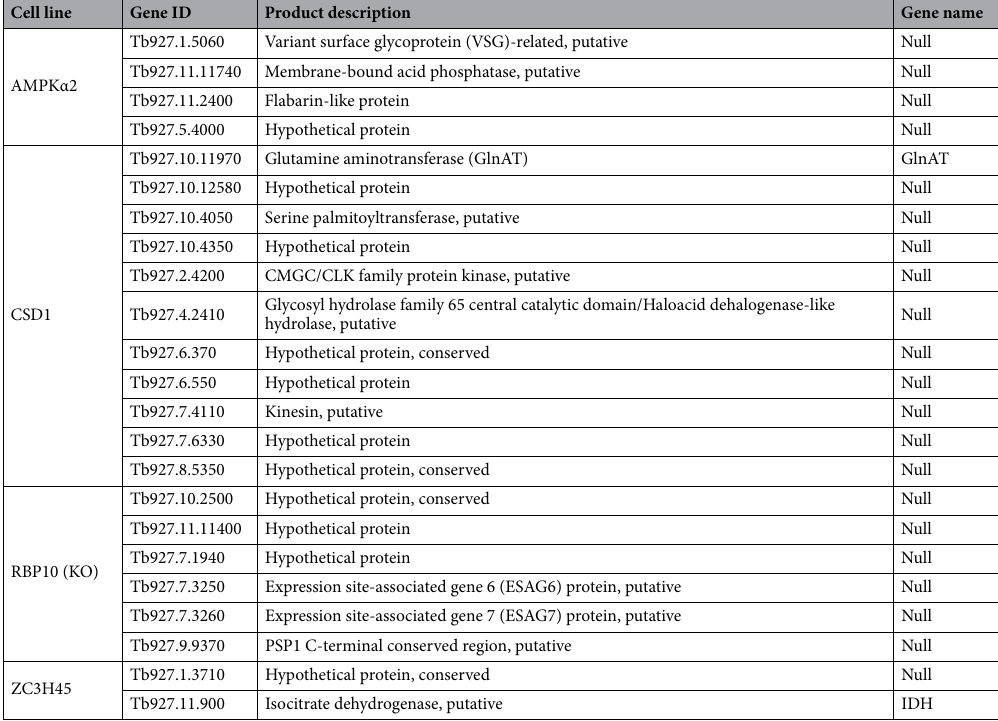
Table 1. Uniquely upregulated transcripts in individual RNAi and KO cell